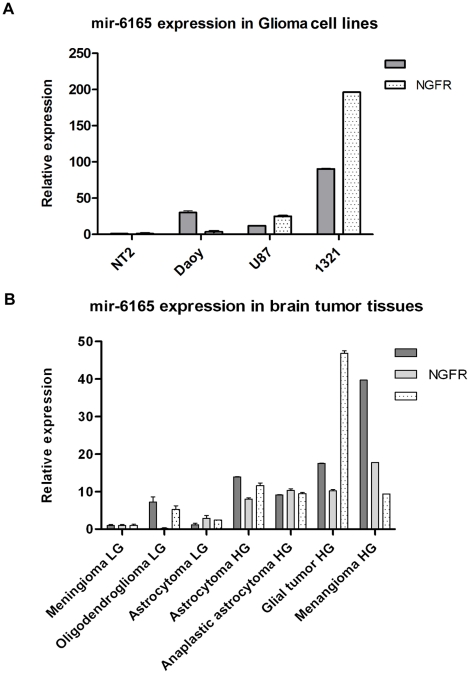
Detection of Hsa-mir-6165 in the brain derived cell lines and biopsies.A) NGFR and mir-6165expression profile in some glioma cell lines is compared to non-glioma NT2 cell line Daoy, 1321N1, U87 (glioma cell lines) and NT2 (non glioma cell line) were used for detection of Hsa-mir-6165 expression. U48 small neucleolar RNA was used as internal control for the amplifications. In glioma cell lines Hsa-mir-6165 expression level was higher than NT2 cell line. B) Relative, Hsa-mir-6165 and its precursor expression levels in various human glioma tissue samples. The expression level of Hsa-mir-6165 in the tumor samples were compared to the lowest grade of tumors. U48 small nucleolar RNA gene (SNORD48) was used for normalizing the expression levels. Error bars indicate standard deviation (SD) of duplicate experiments. Pearson’s test confirmed a positive correlation between NGFR and its intronic miRNA (p = 0.0065). In all of the high grades (HG) tissue samples, the level of NGFR and mir-6165 were higher than the low grad (LG) samples.